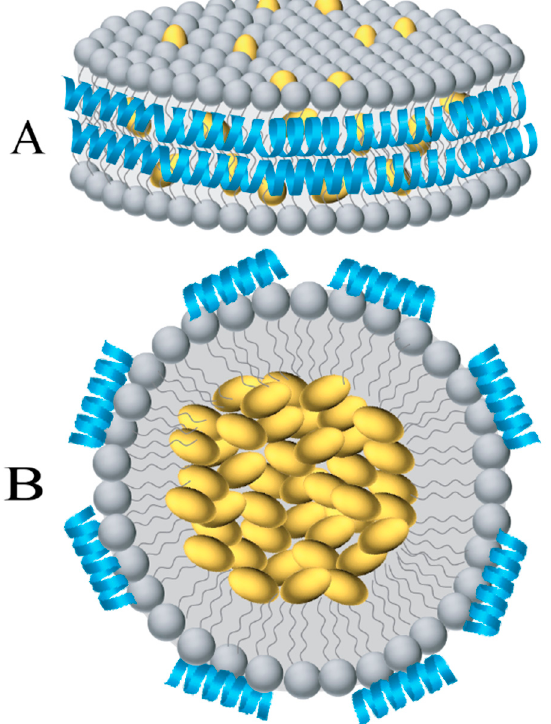
Figure 1. Schematic depiction of discoidal and spherical nanolipoproteins with embedded cargo. ( A ) Discoidal apolipoprotein-based nanostructures (nanodiscs) are composed of a bilayer of phospholipids (grey) with amphipathic α -helices of apolipoproteins (blue) circumscribing the bilayer. ( B ) Cross-section of a spherical lipoprotein composed of a monolayer of phospholipids and small apo-based helical peptides. The phospholipid interior offers an ideal environment to embed hydrophobic and/or amphipathic biomolecules (yellow).